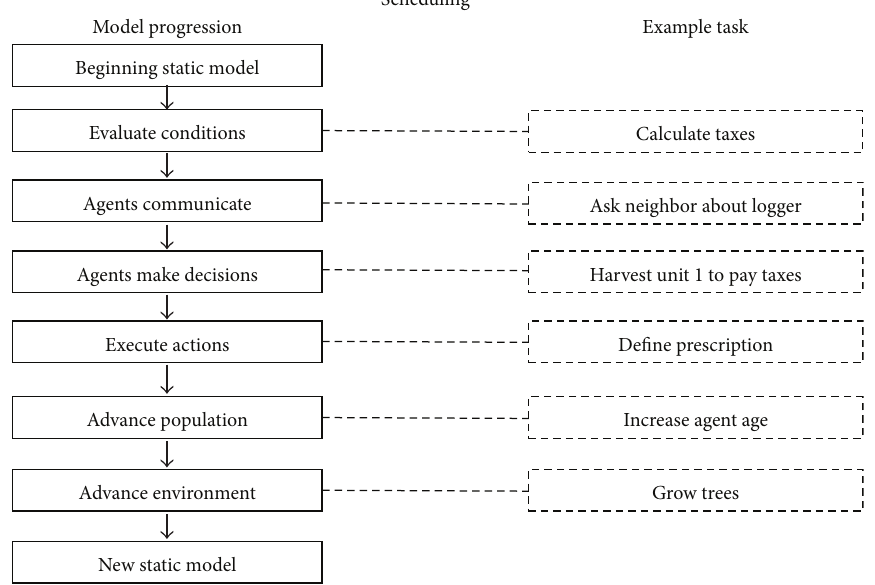
Figure 3: The FLAME scheduling process. The model process started with the evaluation of the static model from the previous year. The next steps included communication, decisions, and action execution. The changes in the landscape and landowner parameters were then updated based on action chosen. The end result was a new static model, used to drive the next